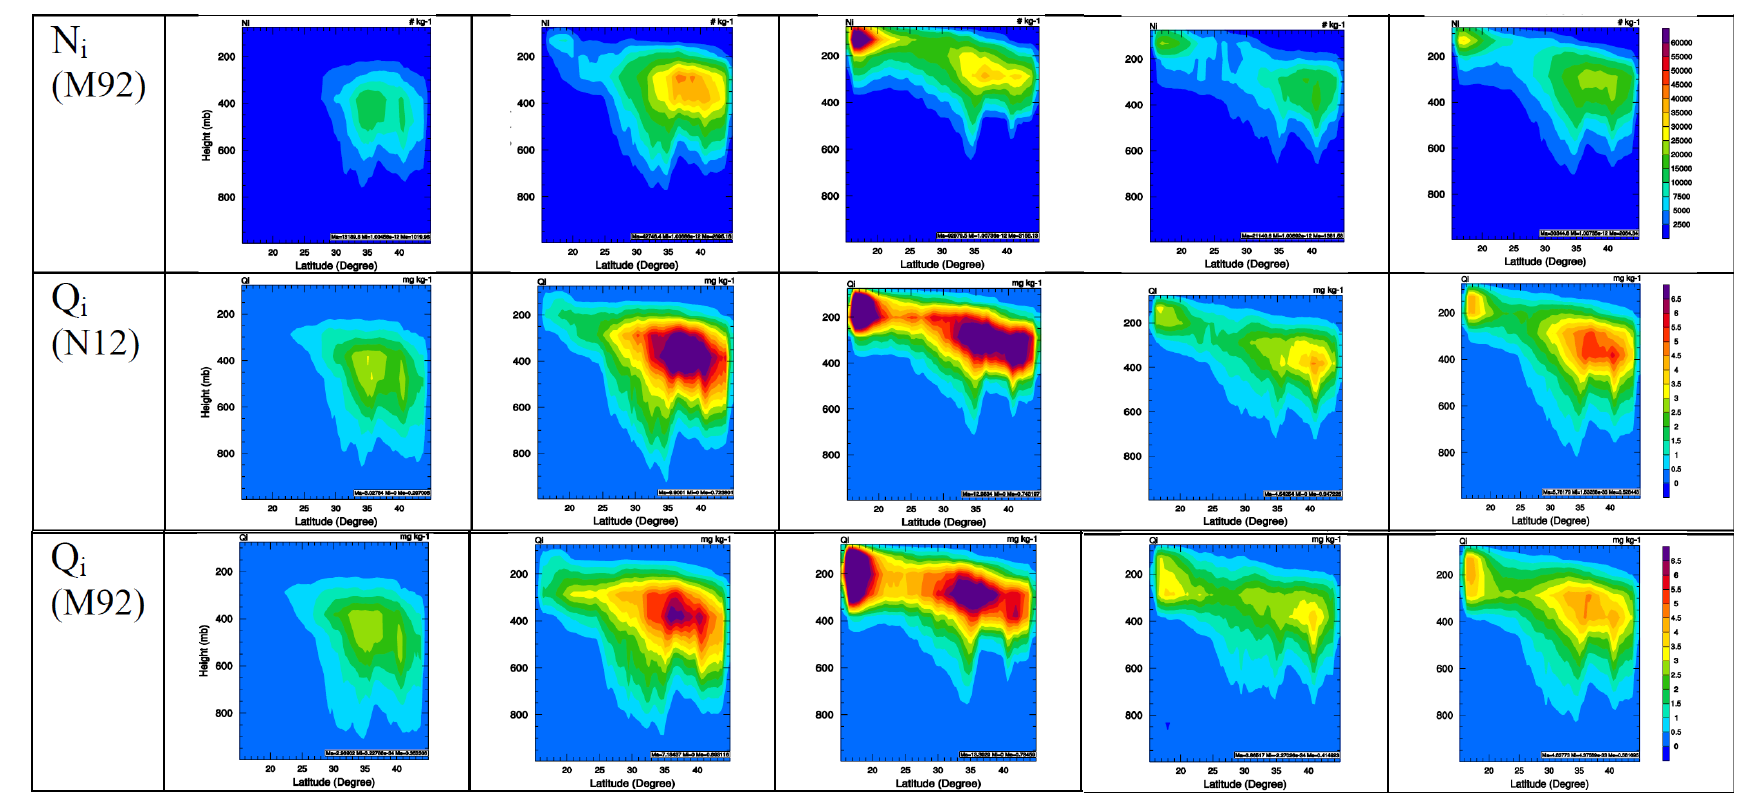
Figure 2. Zonal mean distributions of dust for the 2006 simulations with N12 (row 1) and zonal mean distributions of ICNC, N i , and Q i for the 2006 simulations with N12 and M92 (rows 2–7) over the vertical domain